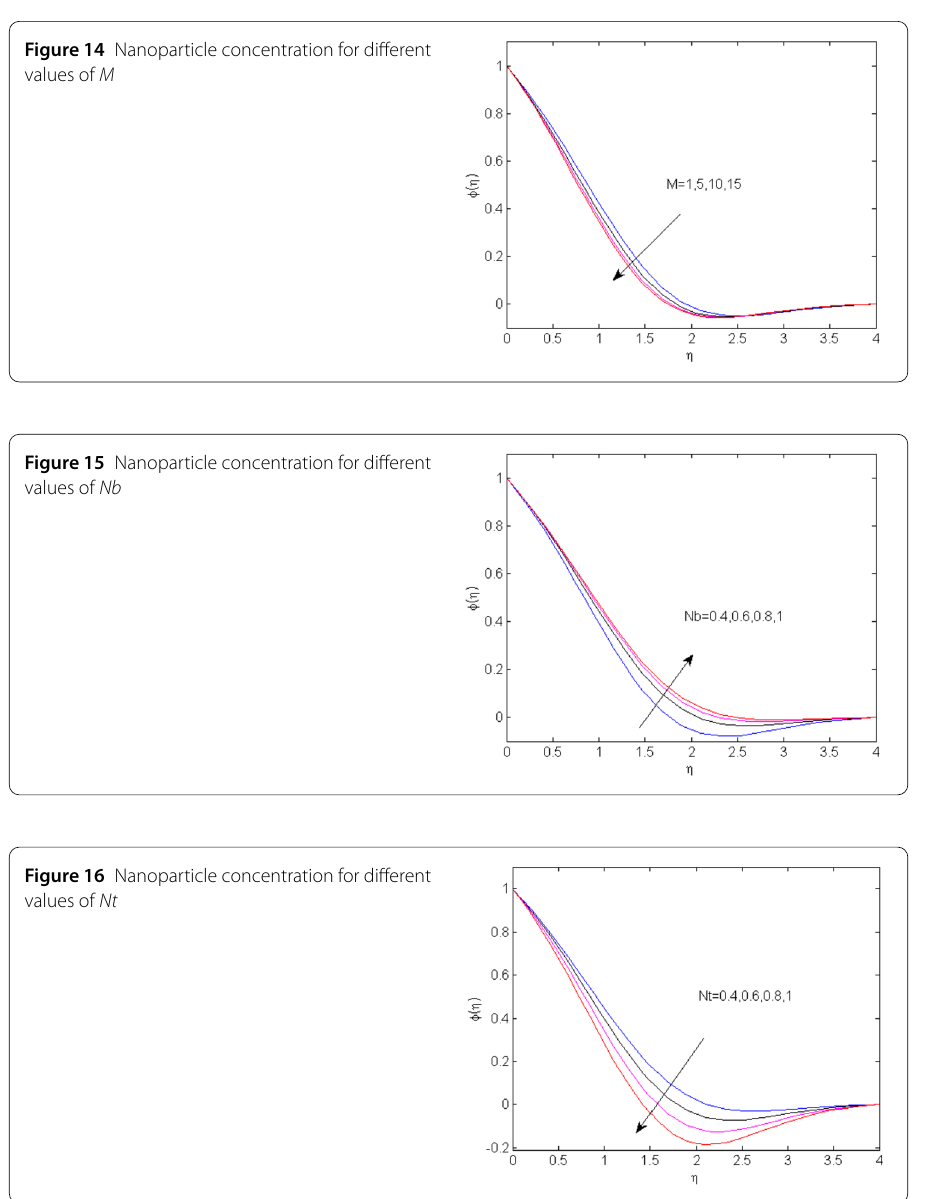
Figure 14 Nanoparticle concentration for different values of M